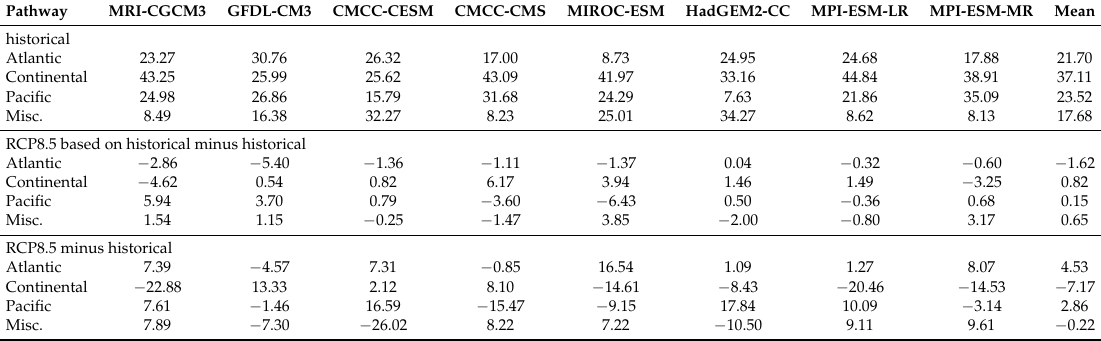
Table 2. Relative occurrence frequencies of each pathway for each model of the historical time frame, and the relative occurrence frequency differences between Representative Concentration Pathway